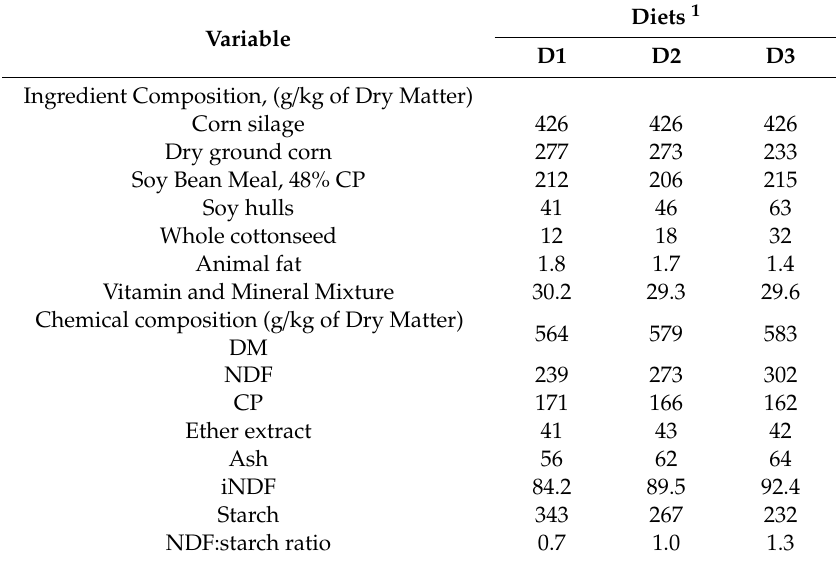
Table 1. Corn silage produced at one farm was used in formulated diets for the whole experiment, and blocks (farms) executed the experimental protocol in parallel to maintain consistency of corn silage across farms. All the other ingredients were purchased from the same source and maintained in each farm separately. Table 1. Ingredient and chemical composition of three diets used in the current experiment. Diets 1 Variable D1 D2 D3 Ingredient Composition, (g / kg of Dry Matter) Corn